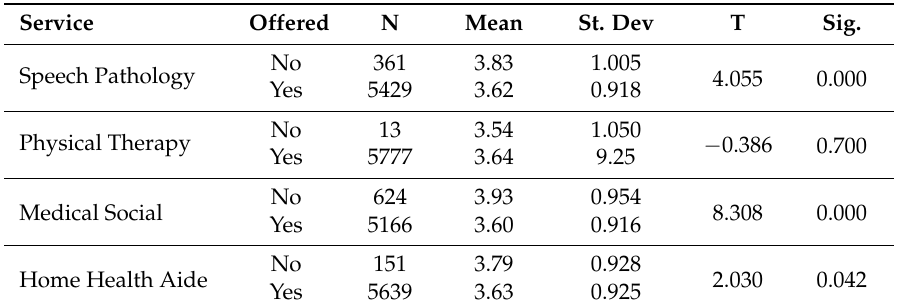
Table 3. Comparison (t-test) of HCAHPS summary rating between HHAs offering specific services vs. not.